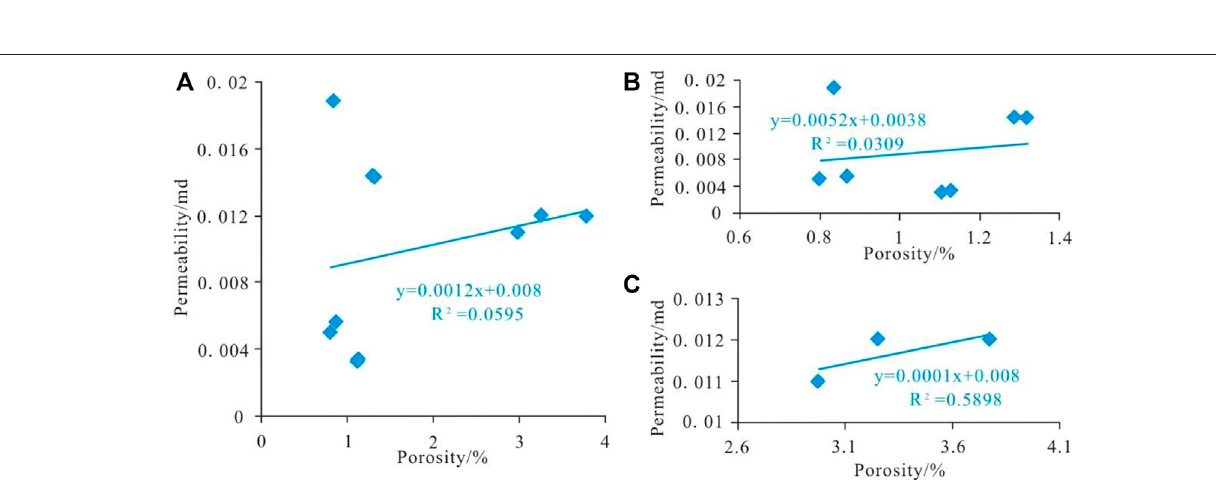
Frontiers in Earth Science |